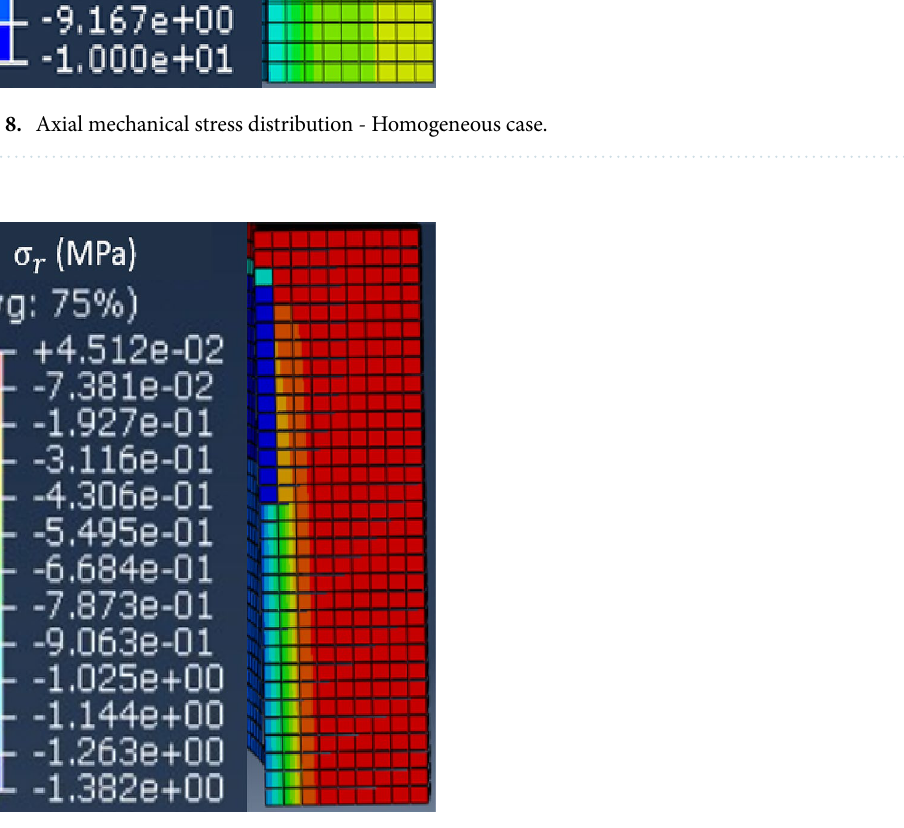
Figure 9. Radial mechanical stress distribution - Homogeneous